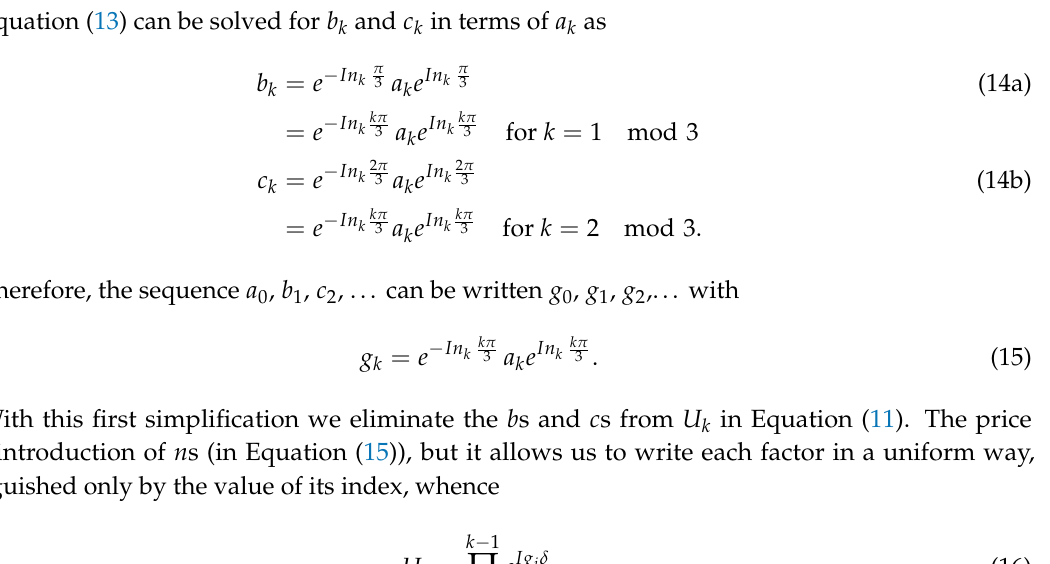
Figure 4. S k , the k th rotation of S 0 = T 0 . n k is the face normal, and unit vectors { a k . b k , c k } are aligned with edges { a k , b k , c k }